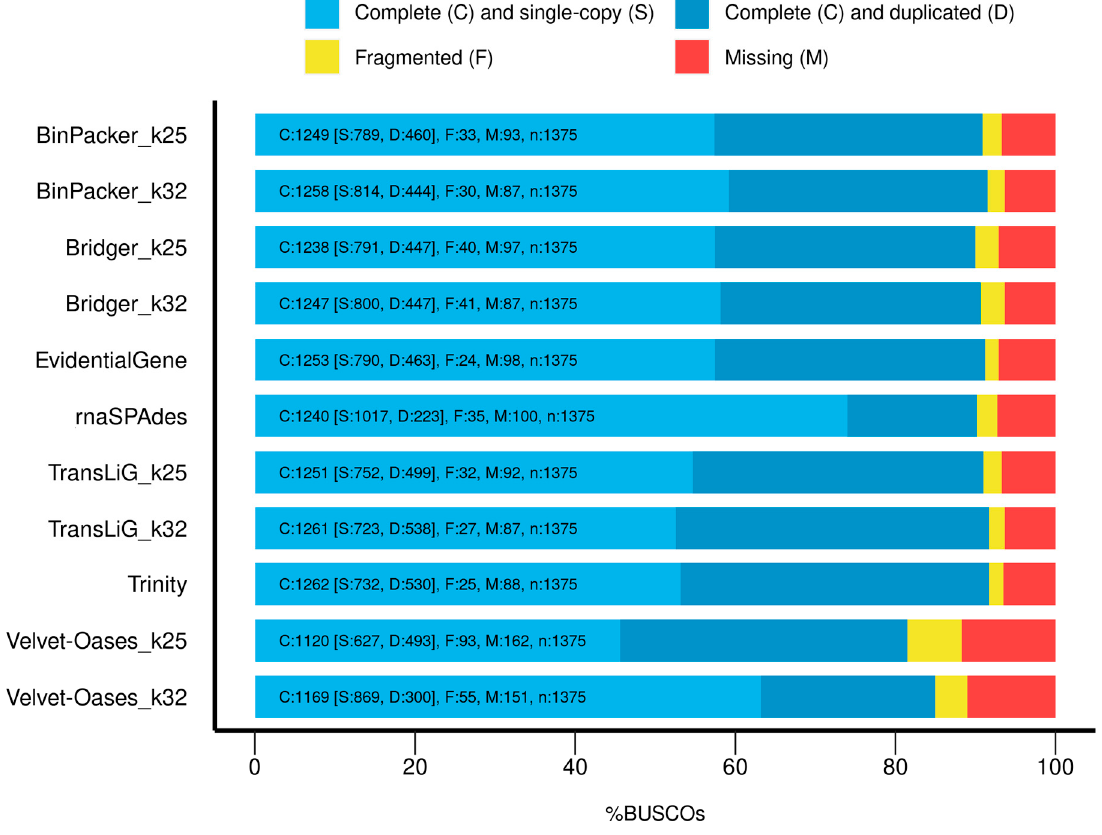
Figure 3. Assessment results of Benchmarking Universal Single-copy Orthologs (BUSCO).